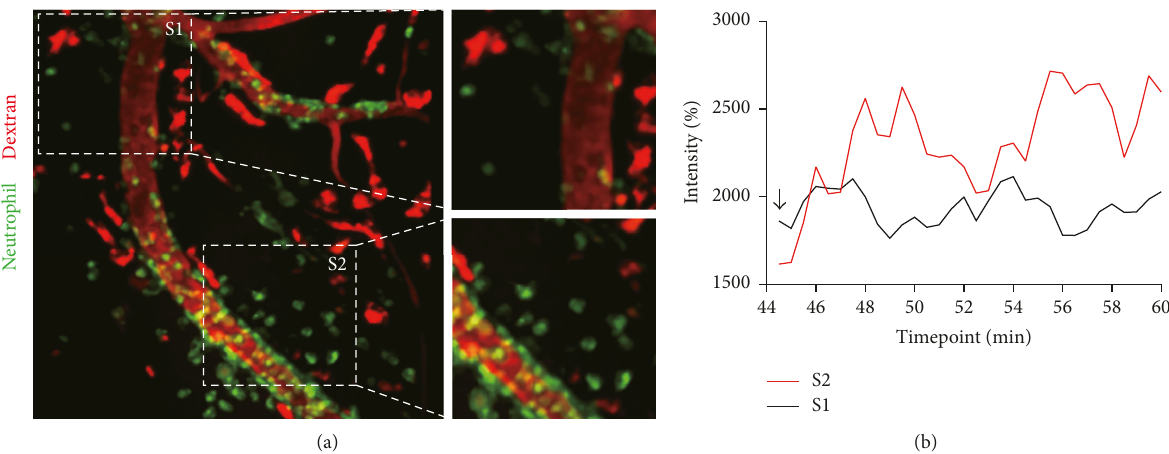
Figure 2: Vascular leakage occurs at specific sites on a vessel despite uniform fMLP treatment. (a) Blood vessels are visualized with dextran, and neutrophils appear green on the image. When fMLP was used to activate neutrophils, the site of leakage was designated as S2 and the area where leakage did not occur was designated as S1 in the same blood vessel (blood leakage occurred at S2, with no apparent change in S1). Scale bar: 30 µ m. See Video 2. (b) When leakage occurred at S1 and S2, blood was extruded and the intensity of red was increased. The graphical display compares the intensity at two areas at 44 to 60min in Video 2. At the time of initial imaging (arrow), the intensity of S1 is higher than that of S2 because the background becomes reddish as overlap occurs due to motion during in vivo imaging. Graph B shows the percent intensity (%) of blood flow in the two areas, as measured by the leakage of